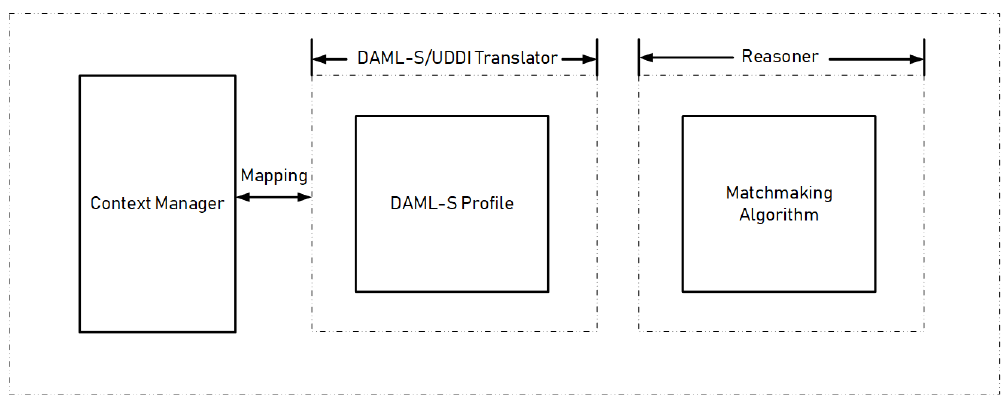
Figure 8. System architecture of a matchmaking